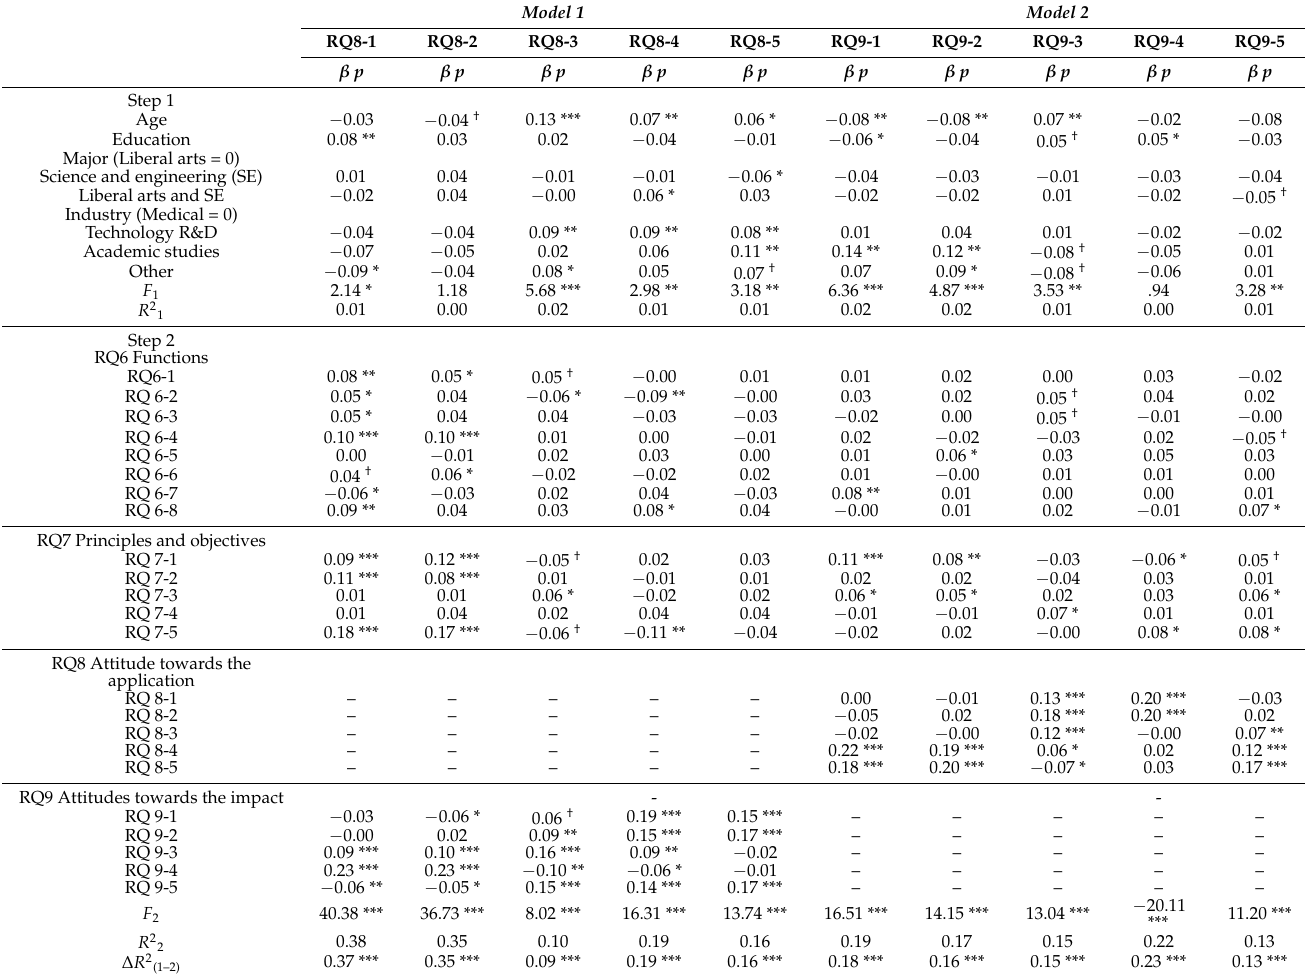
Table 4. Intrinsic associations of respondents’ attitudes towards